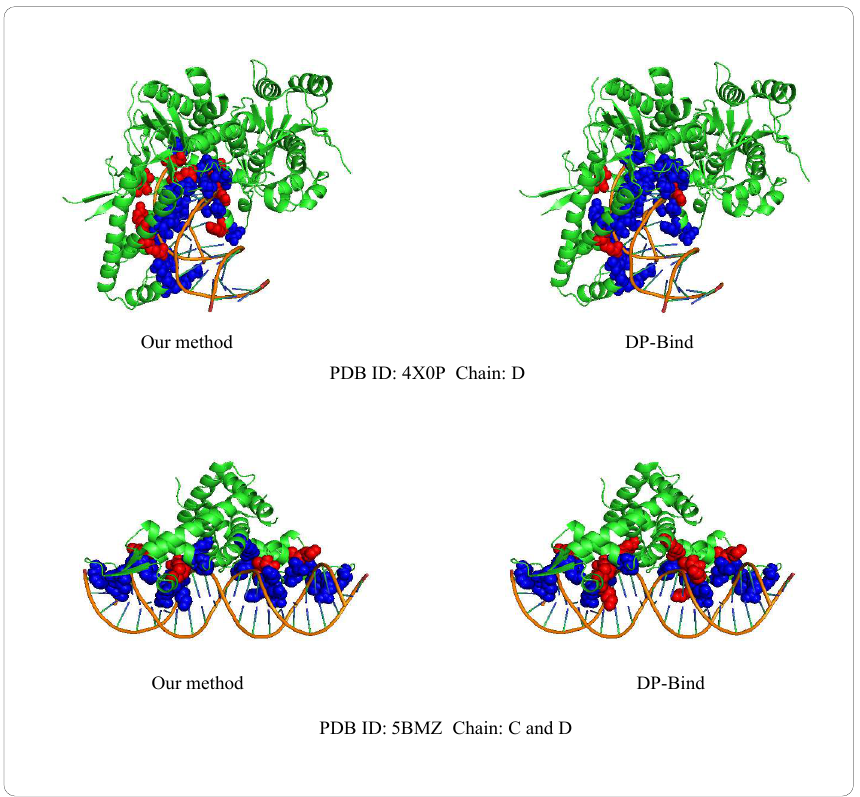
Figure 8. Representative protein-DNA complex: Upper is 4X0P-D (PDB ID: 4X0P, Chain: D), lower is 5BMZ-CD (PDB ID: 5BMZ, Chain: C and